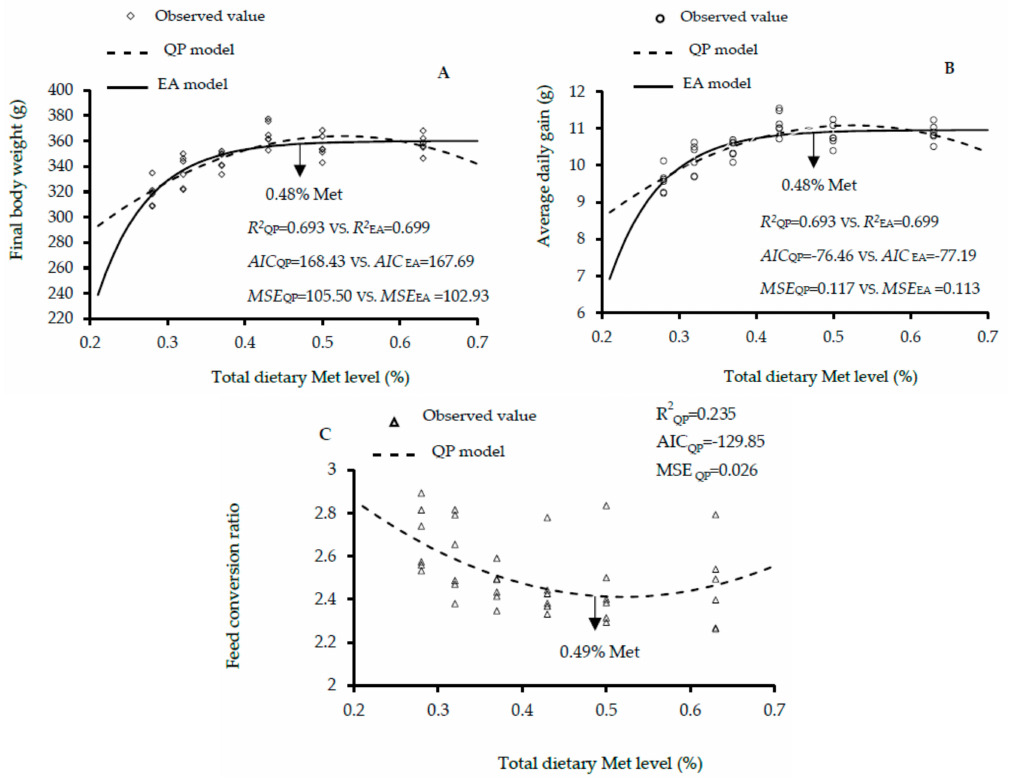
Figure 6. Regression models plot of growth performance as a function of dietary total Met level (0.28%, 0.32%, 0.37%, 0.43%, 0.50%, and 0.63% Met) of mixed sexes of slowly growing yellow-feathered chickens between 0 and 30 days of age. Correlation coe ffi cient ( R 2 ), Akaike information criteria (AIC) and mean squares error (MSE) are indicators of models fitness. ( A ) The optimum response arrow pointing at 0.48% Met by the best fitting model. ( B ) The optimum response arrow pointing at 0.48% Met identified by the best fitting model. ( C ) The optimum response arrow pointing at 0.49%